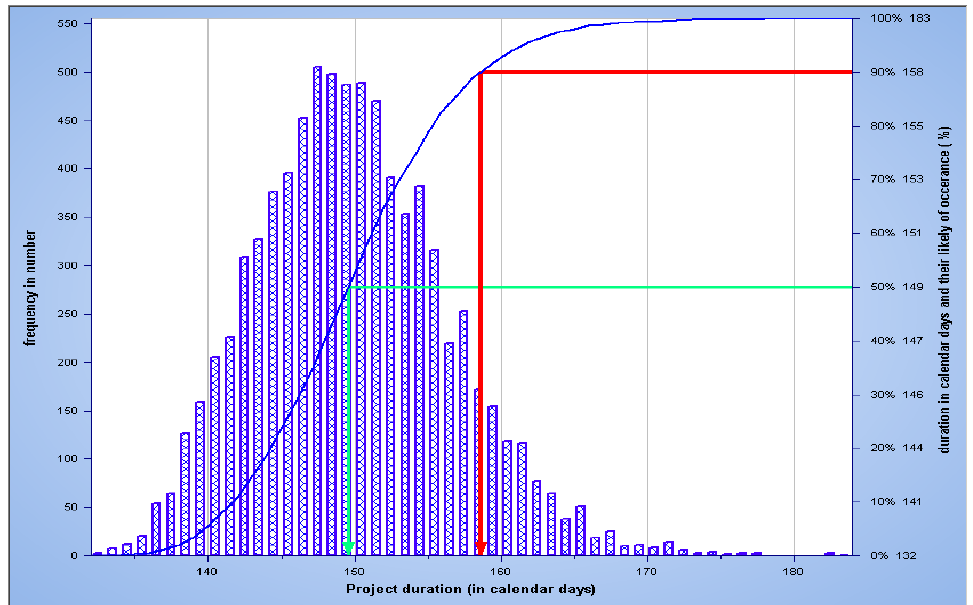
Fig. 8. Results of Monte Carlo simulation using Primavera Risk analysis software (7-day calendar used, mean = 149) (developed by the